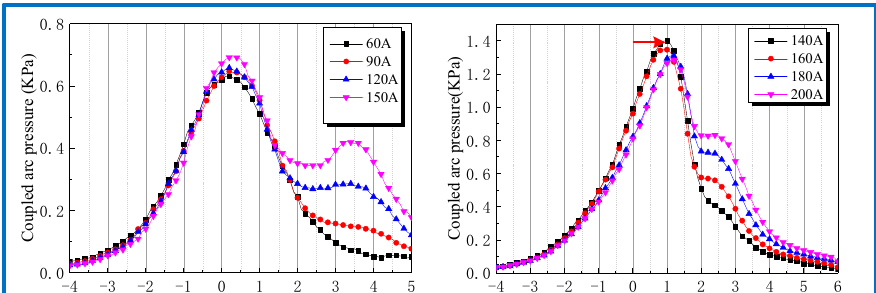
Figure 10. Coupled arc pressure along with welding direction with different current. ( a ) The plasma current is 60 A. ( b ) The plasma current is 120 A.